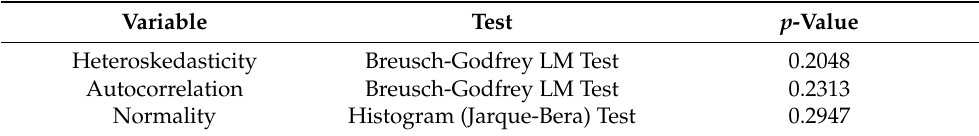
Table 7. Diagnostic